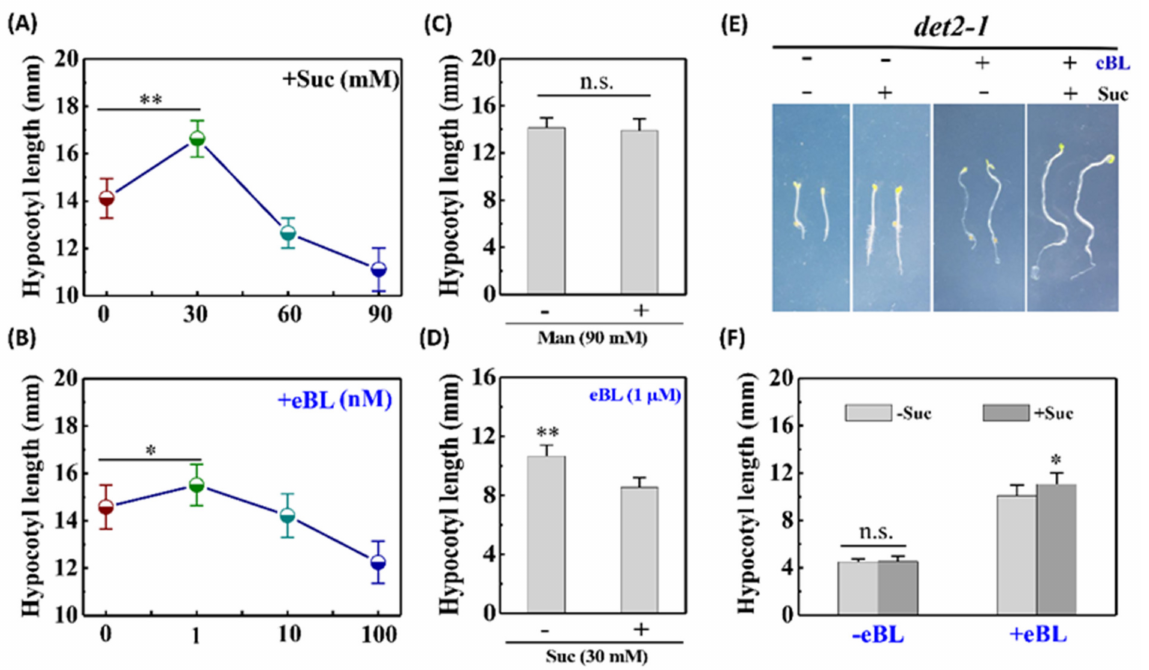
Figure 1. Sucrose promotion of skotomorphogenesis depends on brassinosteroid (BR) biosynthesis. ( A , B ) Hypocotyl length of wild-type (WT) etiolated seedlings grown on medium supplemented with different concentrations of sucrose and eBL, respectively. ( C ) Hypocotyl length of WT etiolated seedlings grown on medium with or without 90 mM mannitol. ( D ) Synergistic effects of exogenous sucrose and eBL. ( E ) Images of 5-day-old dark-grown etiolated seedlings of det2-1 treated with or without 30 mM sucrose ± 1 µ M eBL. ( F ) Hypocotyl length of etiolated seedlings measured in those shown in ( E ). Error bars represent standard deviations ( n > 20). Data were statistically evaluated using Student’s t -test, and the significance of differences (**, p < 0.01; *, p < 0.05; n.s., not significant) is